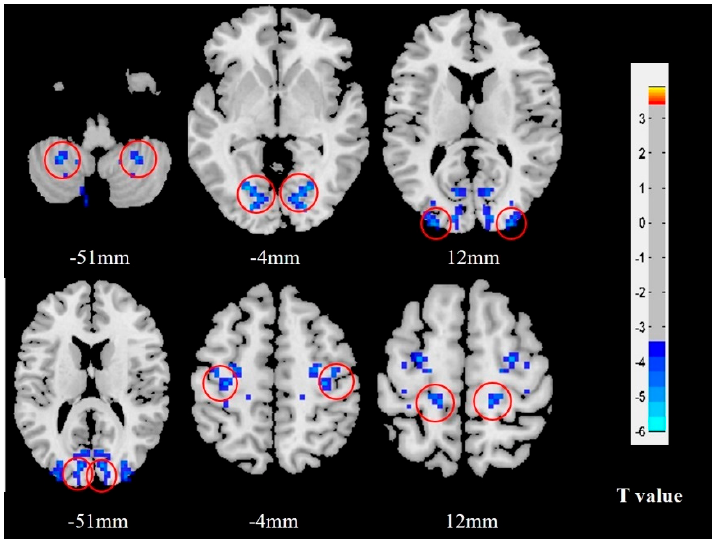
Figure 2. VMHC results in female MwoA patients relative to HCs. Brain regions with notable alterations in VMHC are indicated with red circles. The blue color represents deactivation of neural activity. MwoA patients demonstrated significantly decreased VMHC in the bilateral cerebellum, lingual gyrus, middle occipital gyrus, cuneus, precentral gyrus and postcentral gyrus compared with HCs. Abbreviations: VMHC, voxel-mirrored homotopic connectivity; MwoA, migraine without aura; HCs, healthy controls.